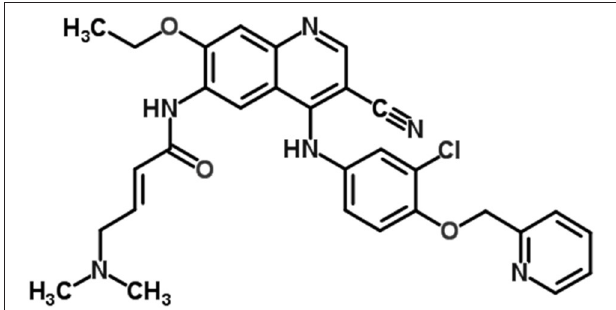
FIGURE 1 | Chemical structure of